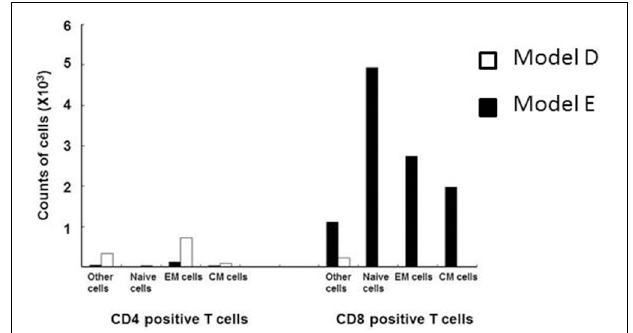
FIGURE 3 | Flow cytometry analyses of CD3 positive lymphocytes from the BALF of models D ( (cid:2) ) and E ( (cid:2) ) at 96h post-intratracheal challenge. CD8-positive cells predominated, and consisted of naïve cells (CD62L + hi / CD44 + lo ), effector memory cells (CD62L + lo /CD44 + hi ), and central memory cells (CD62L + hi /CD44 + hi ), in descending